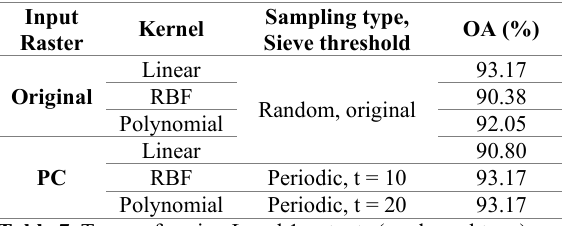
Table 7 . Top-performing Level 1 outputs (per kernel type)